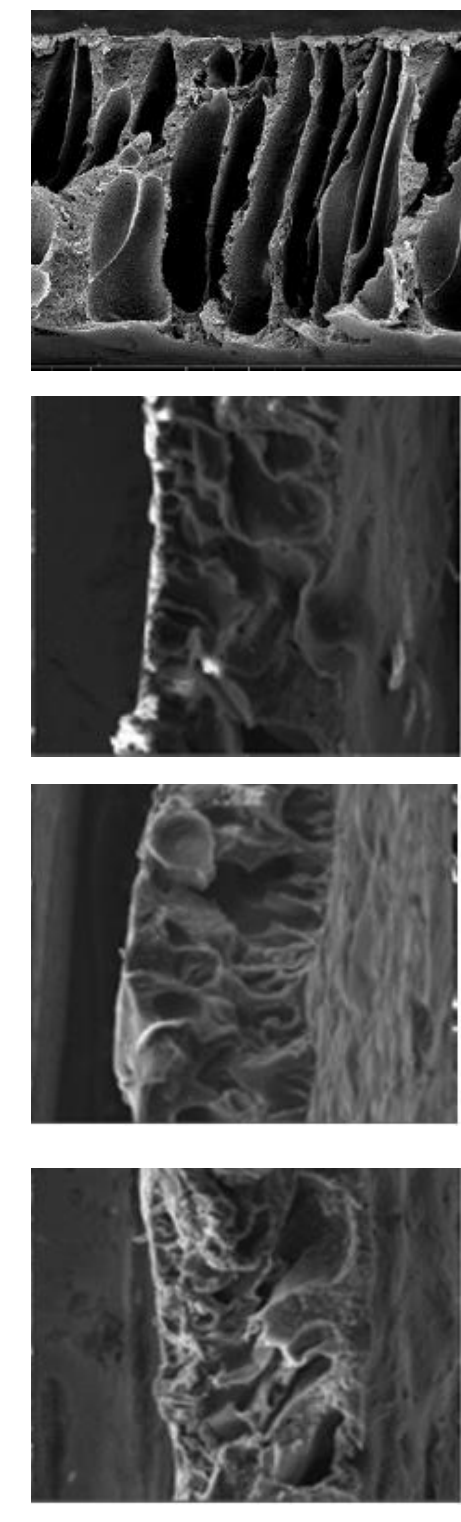
Figure 5. SEM images of the surface (magnification 800) and corresponding cross-section (magnification 2000) ( a ) Pure CTA, ( b ) 0.1 wt% CA/GO, ( c ) 0.3 wt% CA/GO, and ( d ) 0.5 wt% CA/GO.